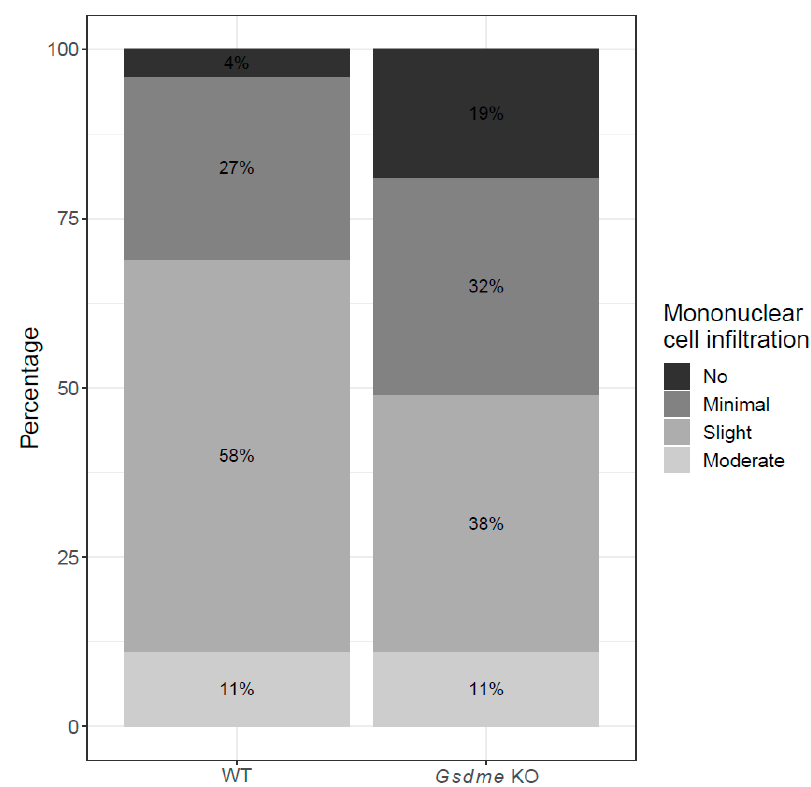
Figure 6. Percentage of adenocarcinomas with different grades of mononuclear cell infiltration in WT and Gsdme KO mice. Slight inflammation was more often associated with adenocarcinomas in WT mice compared to Gsdme KO mice, while in the latter group more often no inflammation was present.